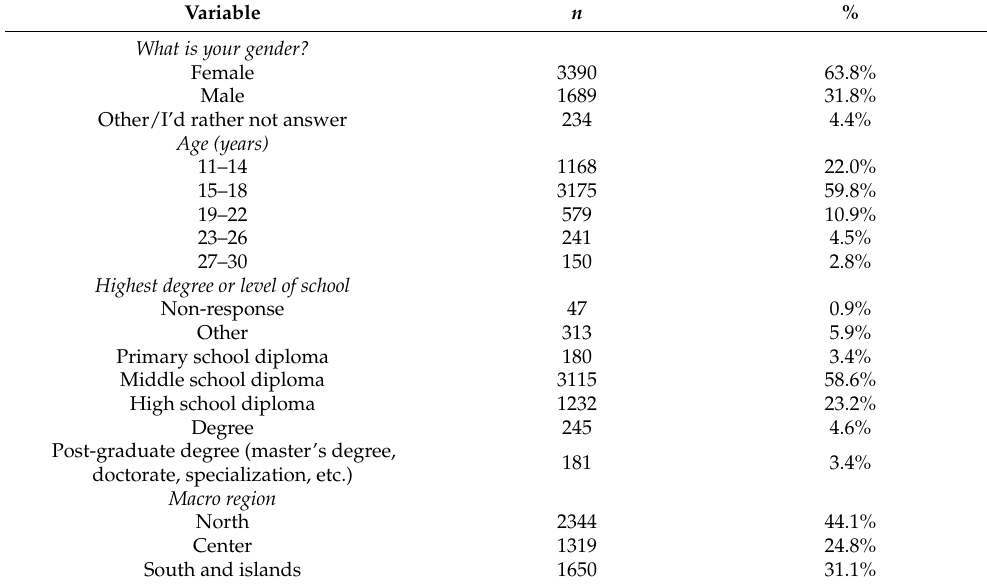
Table 1. Characteristics of the